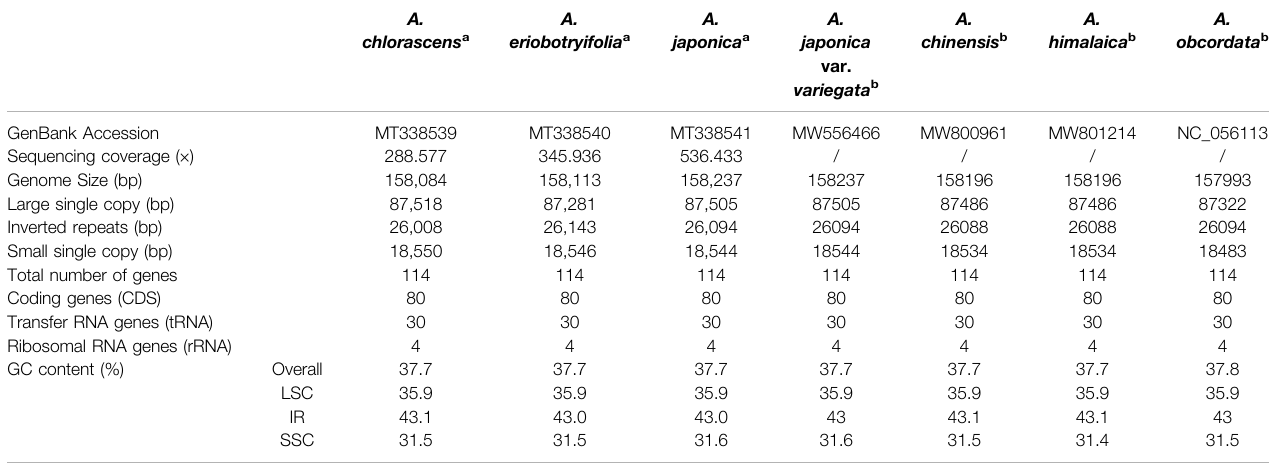
TABLE 1 | Features of Aucuba